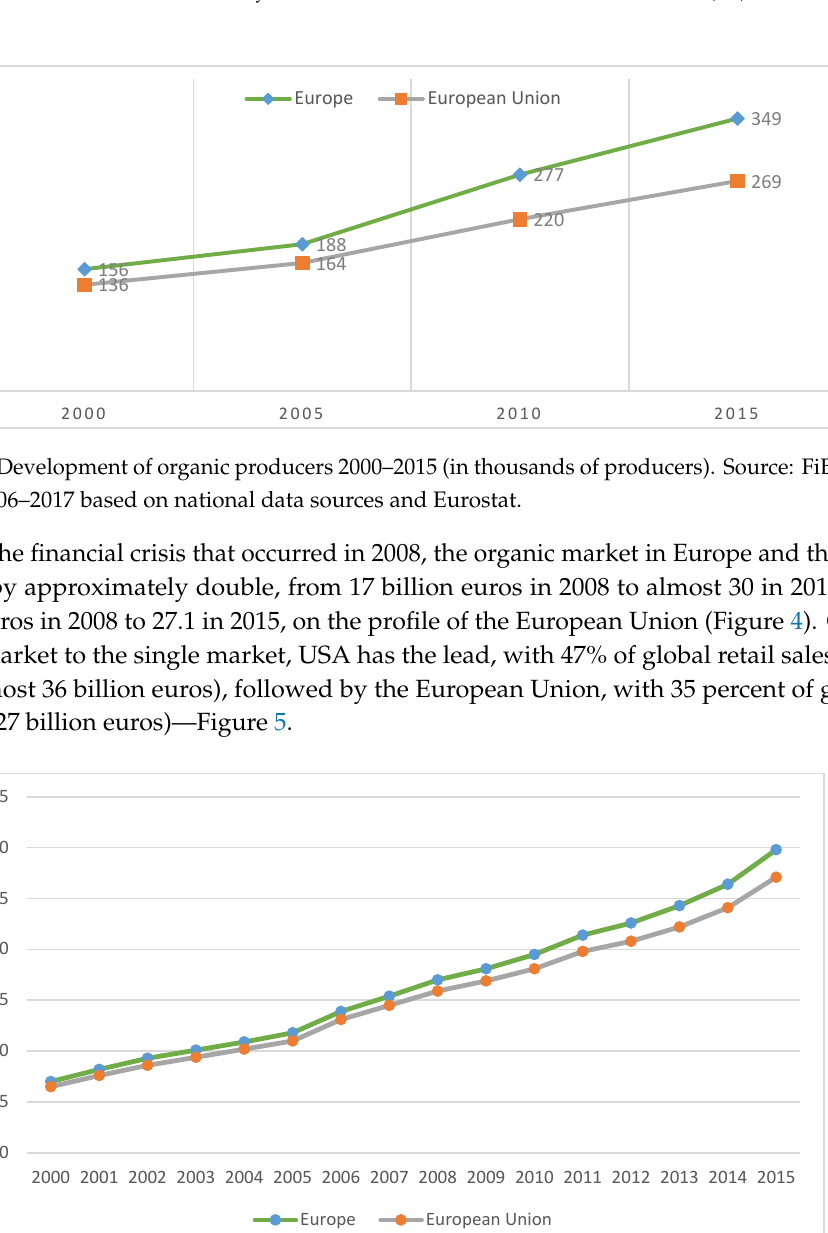
Figure 5. Distribution of retail sales by country and by single market worldwide. Source: FiBL- AMI survey 2017 based on national data sources.